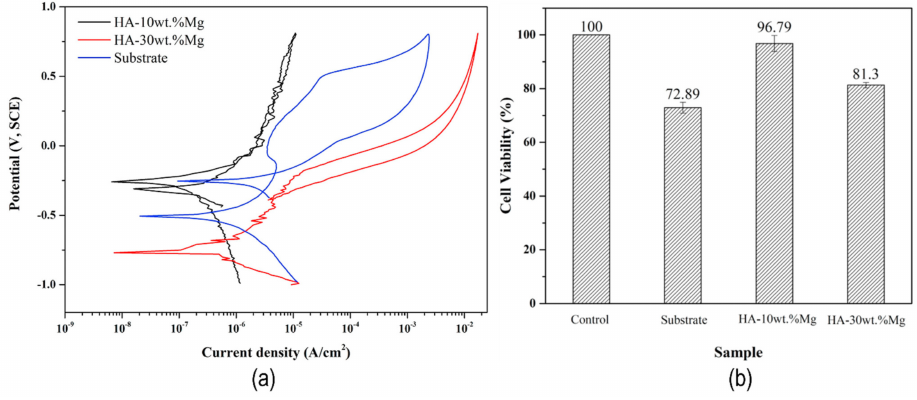
Figure 8. ( a ) Corrosion potential ( b ) Cell viability. Reprinted with permission from